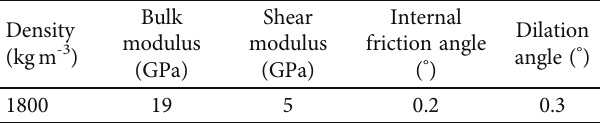
Table 3: Parameters of double-yield materials in 2-2